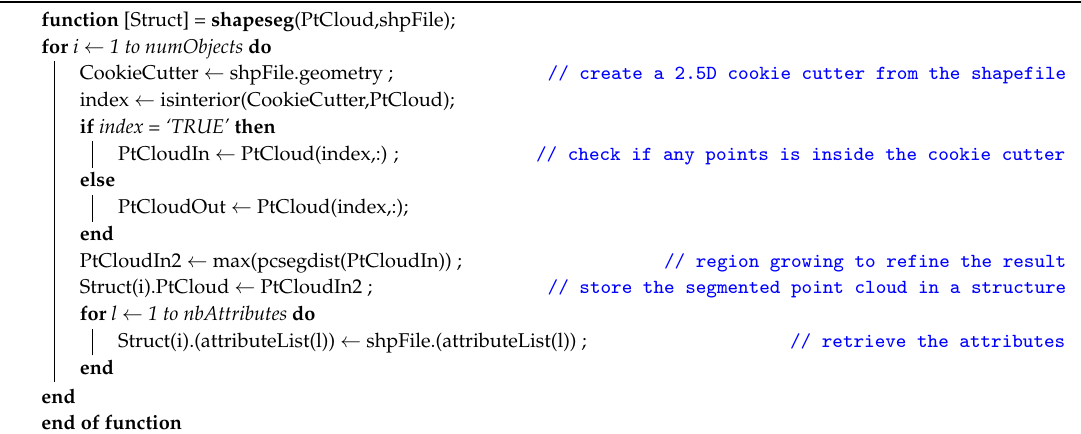
Algorithm 1: Semantic segmentation of heritage complexes aided by GIS